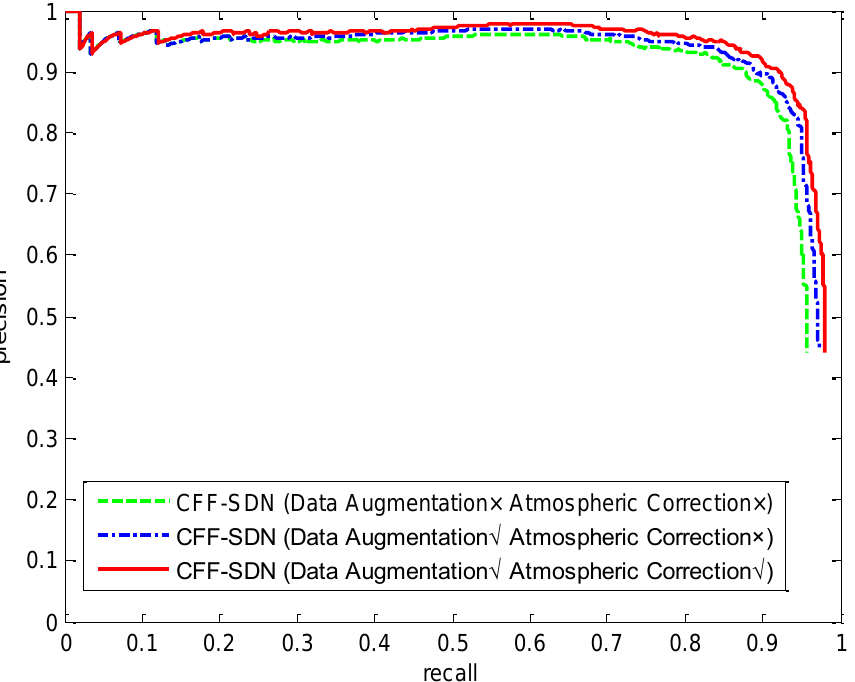
Figure 18. Precision–recall curves of CFF-SDN model with data preprocessing and CFF-SDN model without data preprocessing.